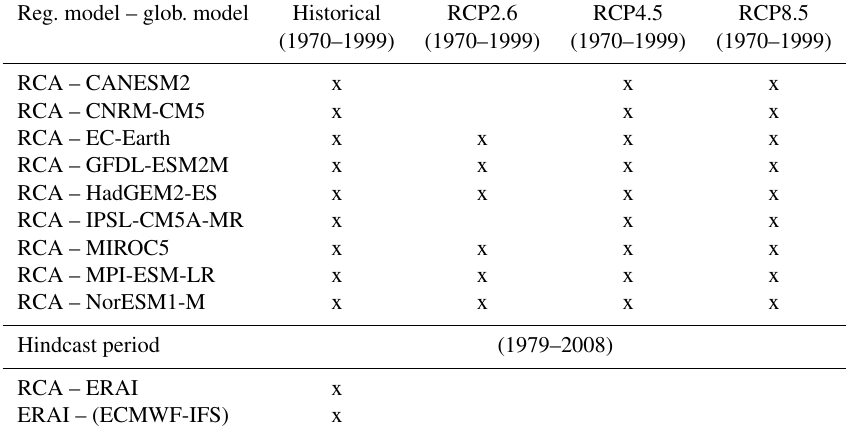
Table 2. Overview of the 34 regional RCA simulations grouped by GHG emission scenarios and downscaled global models. For validation purposes, an RCA-ERAI hindcast was carried out for subsequent comparison with the ERAI hindcast data set. Due to technical issues, RCP2.6 scenarios for RCA – IPSL-CM5A-MR, RCA – CanESM2, and RCA – CNRM-CM5 could not be